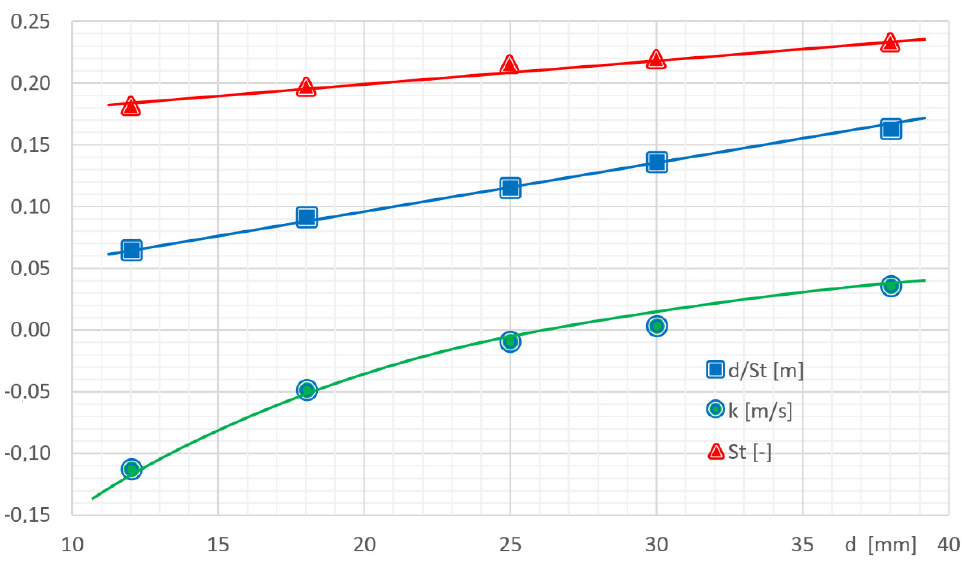
Figure 18. Influence of the characteristic dimension on the parameters of Equation (3).